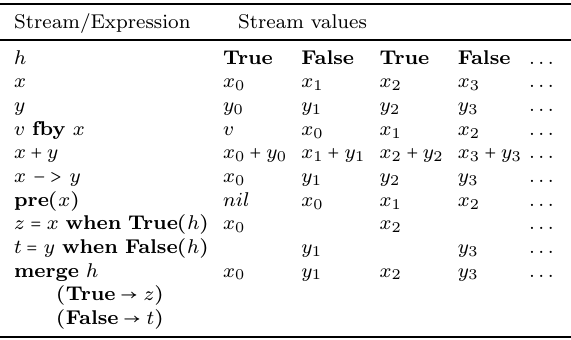
Table 2: Examples for applying the SDFK operators Stream/Expression Stream values h True False True False ... x x 0